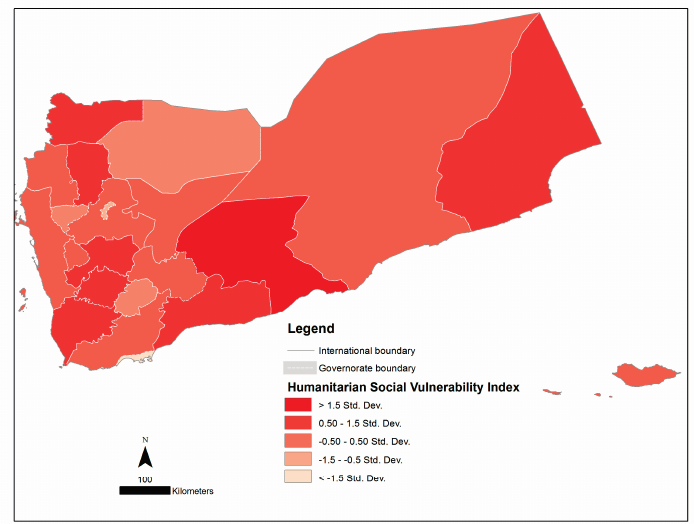
Figure 5. Social Vulnerability Index to Humanitarian Crisis of governorates in Yemen